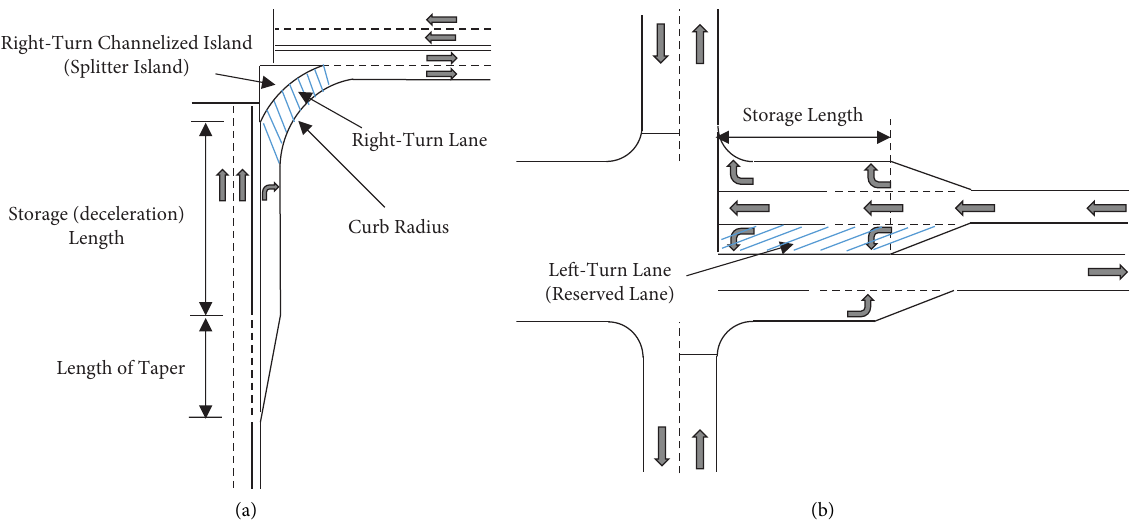
Figure 2: Geometric design elements for turning movement at an intersection: (a) single right-turn lane and (b) single left-turn